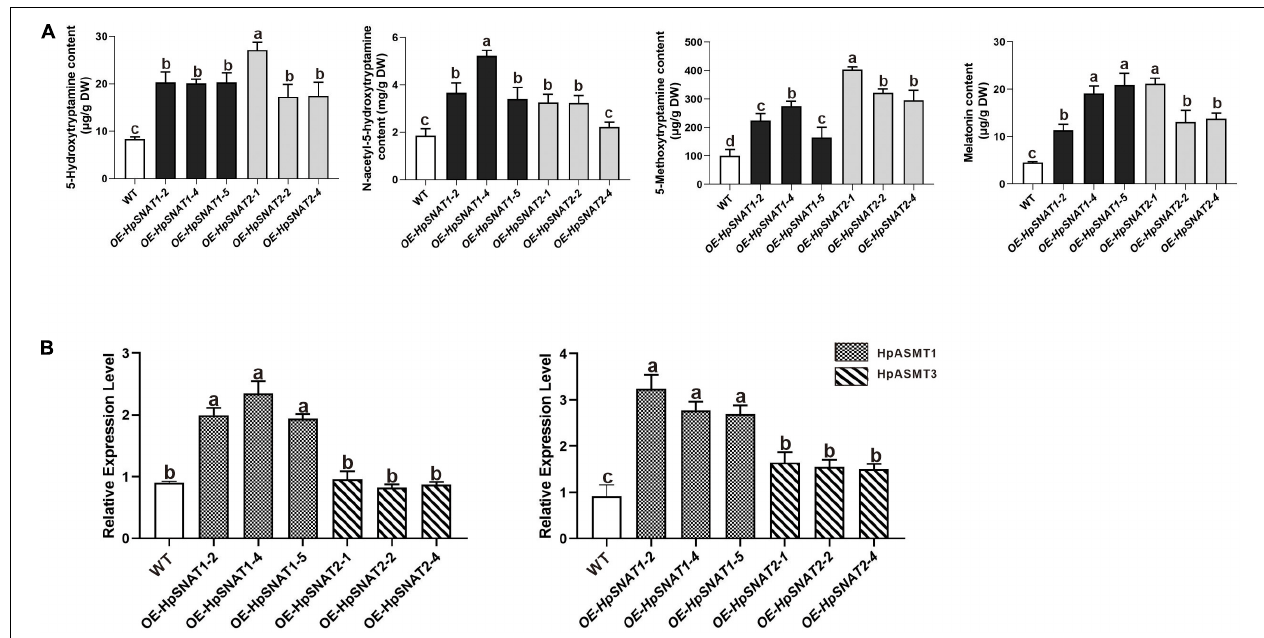
FIGURE 6 | Secondary metabolites contents and expression patterns of HpASMT in H. perforatum . (A) Comparisons of 5-HT, 5-MT, NAS, and melatonin in OE and control of H. perforatum plants. (B) Relative quantitative analysis of HpASMT1 and HpASMT3 in transgenic lines and control of H. perforatum plants. Data were normalized by HpACT2 (MK054303), calculated with the equation 2 −(cid:52)(cid:52) Ct . All data represent averages of three biological replicates, error bars indicate ±